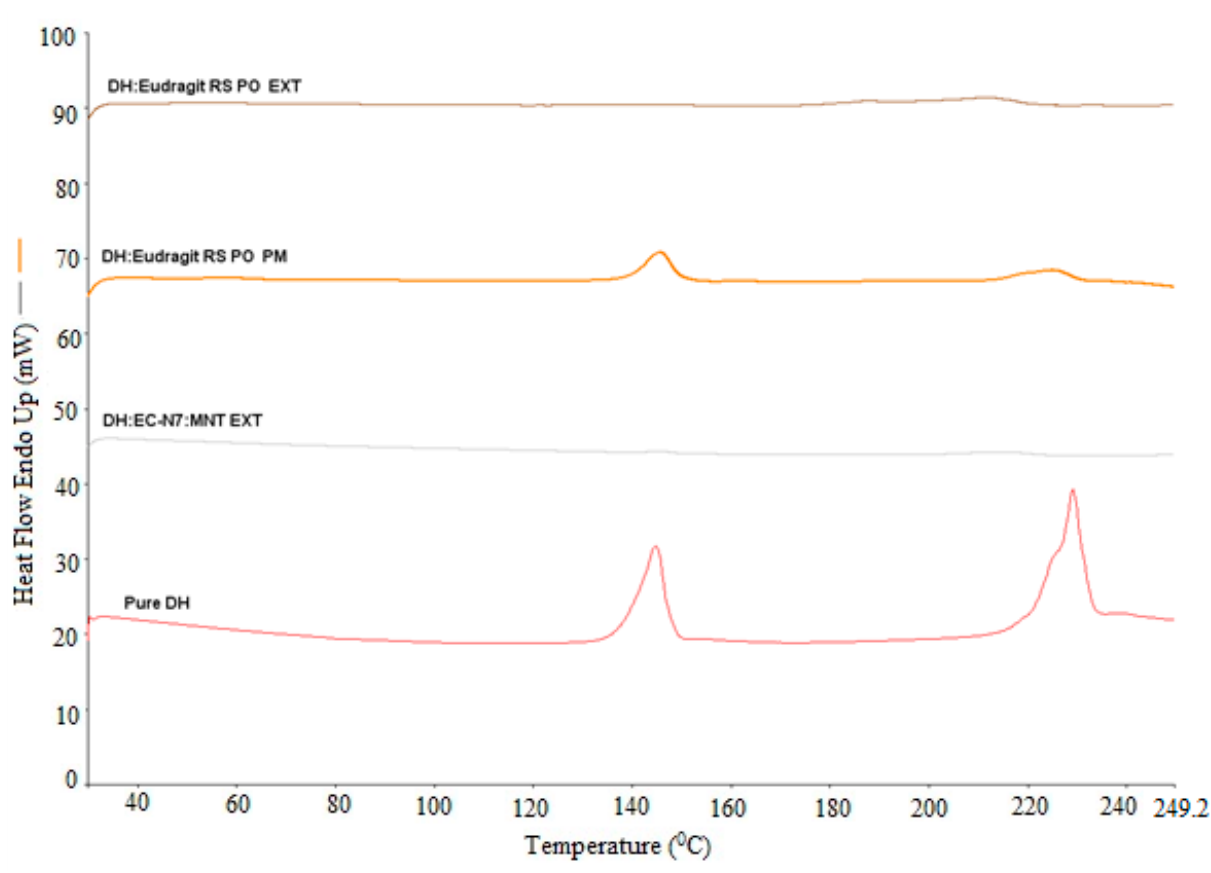
Figure 4. DH/C-888/EC-N7(1:1:1) and DH/EC-N7(1:2) DSC studies performed at temperatures of 30–250 °C and a heating rate of 20 °C/min.